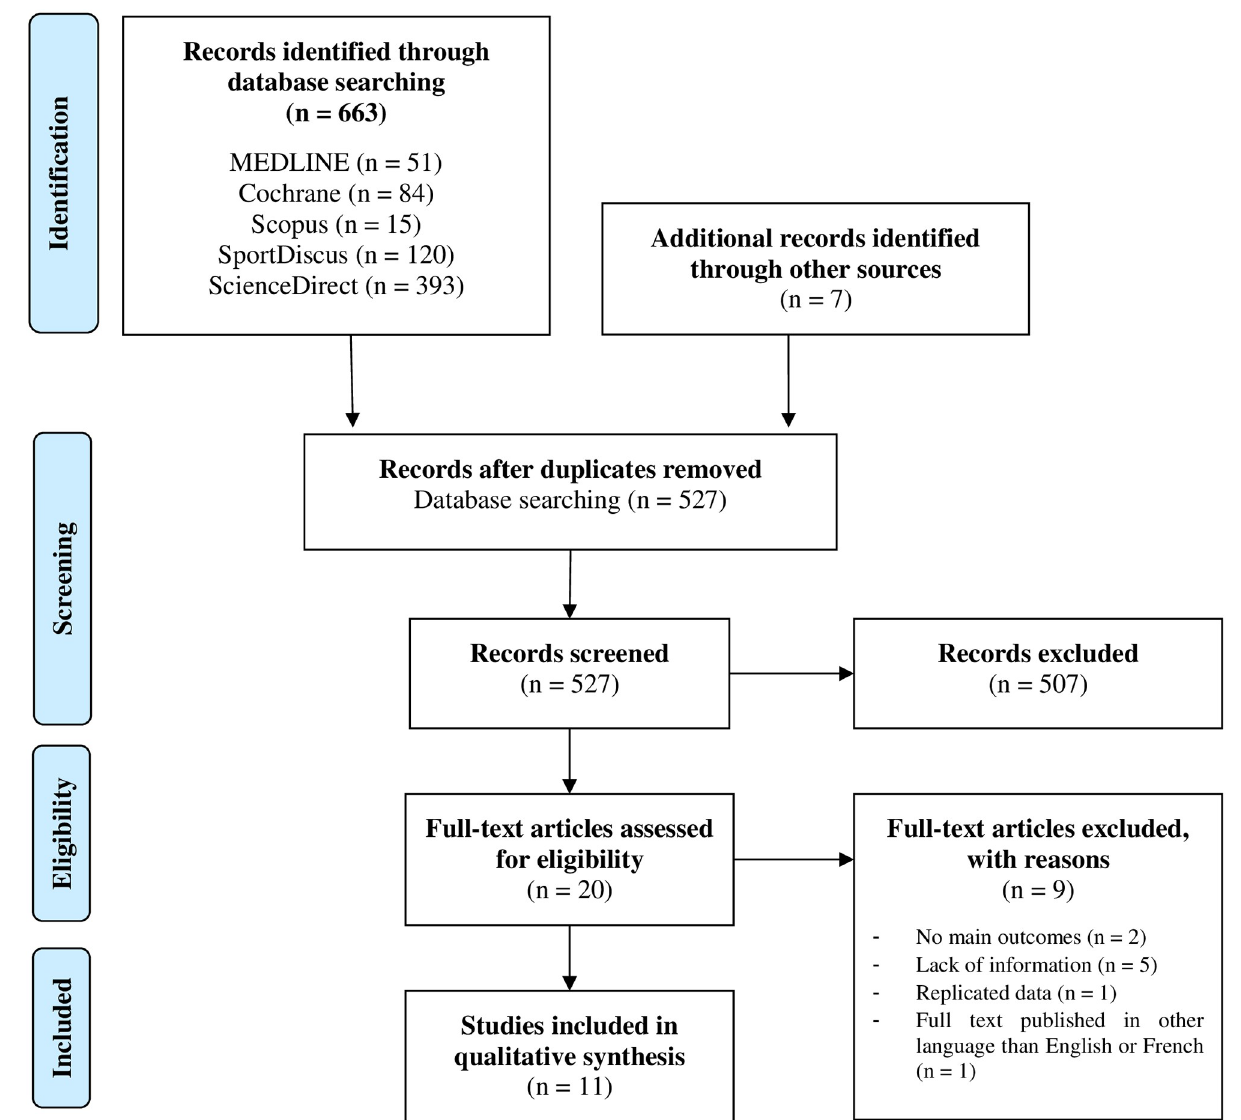
Fig 1. Process of elimination and inclusion of studies for review based on PRISMA